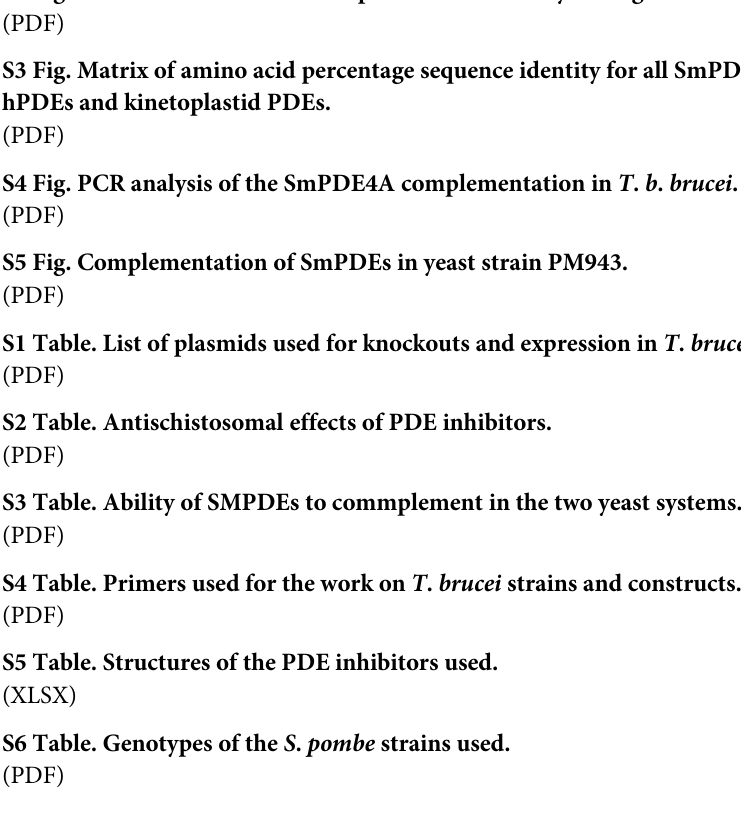
S2 Fig. PCR of SmPDE9C in multiple S . mansoni lifecycle stages. S3 Fig. Matrix of amino acid percentage sequence identity for all SmPDEs and examplar hPDEs and kinetoplastid PDEs. S4 Fig. PCR analysis of the SmPDE4A complementation in T . b . brucei . S5 Fig. Complementation of SmPDEs in yeast strain PM943. S1 Table. List of plasmids used for knockouts and expression in T . brucei . S2 Table. Antischistosomal effects of PDE inhibitors. S3 Table. Ability of SMPDEs to commplement in the two yeast systems. S4 Table. Primers used for the work on T . brucei strains and constructs. S5 Table. Structures of the PDE inhibitors used. S6 Table. Genotypes of the S . pombe strains